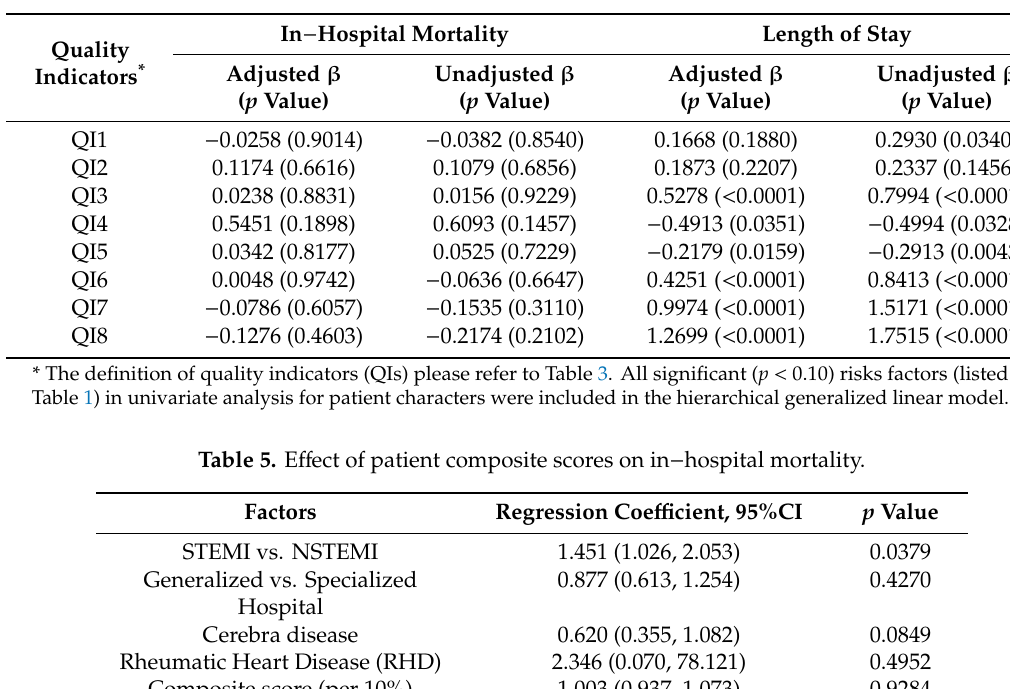
Association of process measures with clinical outcomes among acute myocardial infarction patients.